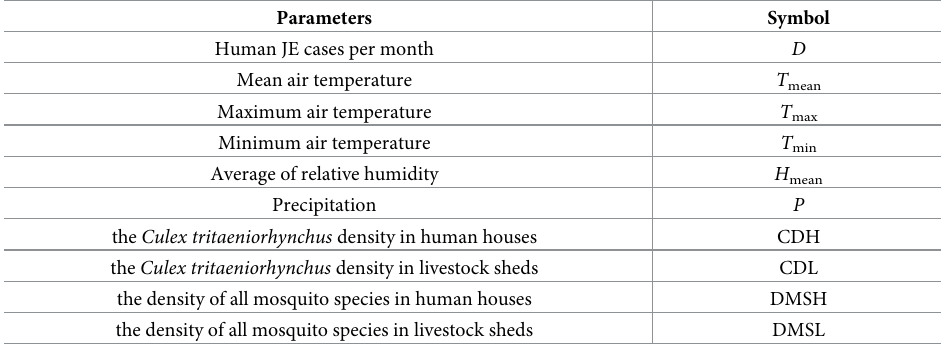
Table 1. The feature parameters used in this